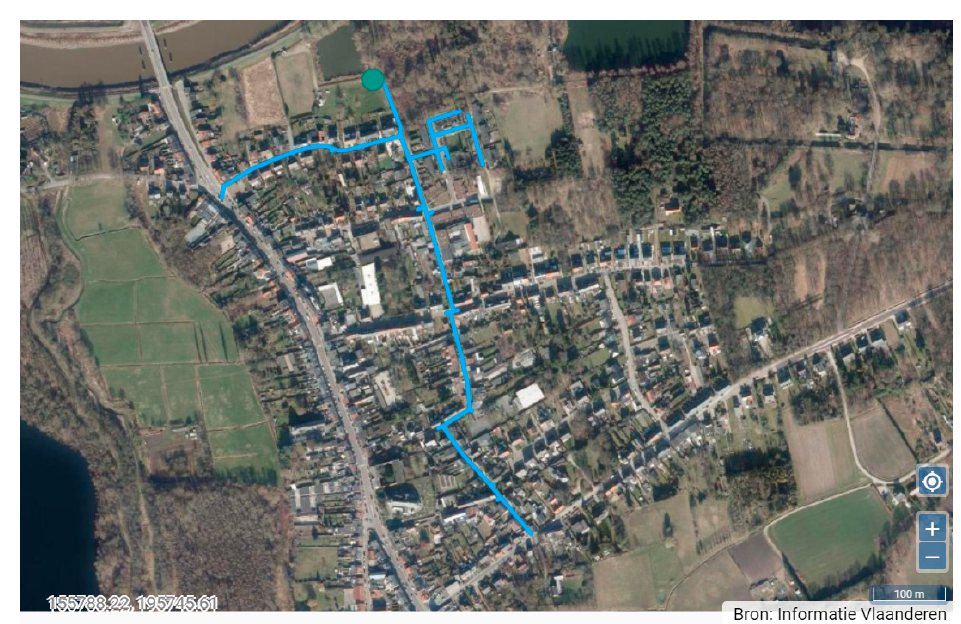
Figure A1. Overview of the catchment in Wilsele. The green dot shows the inspection well where the samples were taken. The blue area is connected to this inspection well.